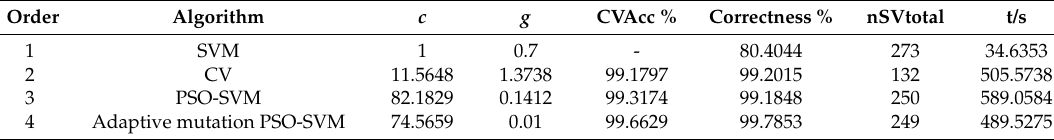
Table 4. Comparison of evaluation index of parameter optimization